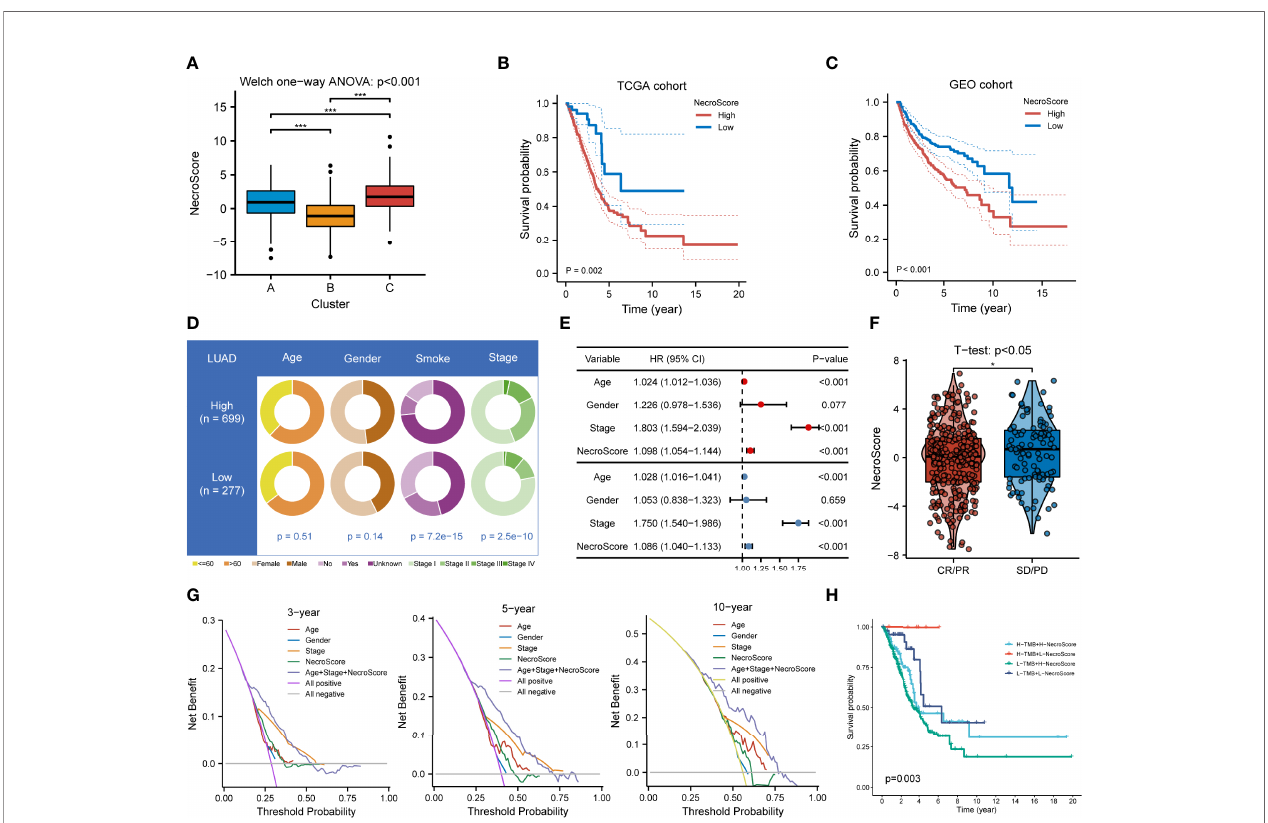
FIGURE 6 | Clinical signi fi cance of NecroScore. (A). A Welch one-way ANOVA test con fi rmed the NecroScore at three distinct levels of necroptosis. The line in the box represents the median value, and the black dots represented outliers. Asterisks indicated p-value (***p<0.001). (B, C). Kaplan-Meier curves and log-rank test showed signi fi cant differences of overall survival probability between the low- and high-NecroScore groups in the TCGA-LUAD and GEO-meta cohorts, respectively. (D). The pie chart showed variations of clinicopathologic characteristics of lung adenocarcinoma between the low-and high-NecroScore groups by Fisher ’ s exact test. (E). A univariate (upper part) and multivariate (lower part) Cox model showed the independent prognostic values of age, pathologic stage, and the NecroScore shown by a forest plot. (F). Distribution of the NecroScore in distinct groups after primary therapy response group (CR, complete response; PR, partial response; SD, stable disease; PD, progressive disease) was revealed by t-test. (G). Decision analysis showed the clinical ef fi ciency of the NecroScore. The x-axis represented the threshold probability threshold, and the y-axis represented the net bene fi t of 3, 5, and 10 years. The combination of age, pathologic stage, and the NecroScore exhibited the highest net bene fi t stably. (H) . Survival analysis for patients with different tumor mutation burden and NecroScore strati fi cations was performed by log-rank test and visualized by Kaplan-Meier curves. “ H ” represented high and “ L ” represented